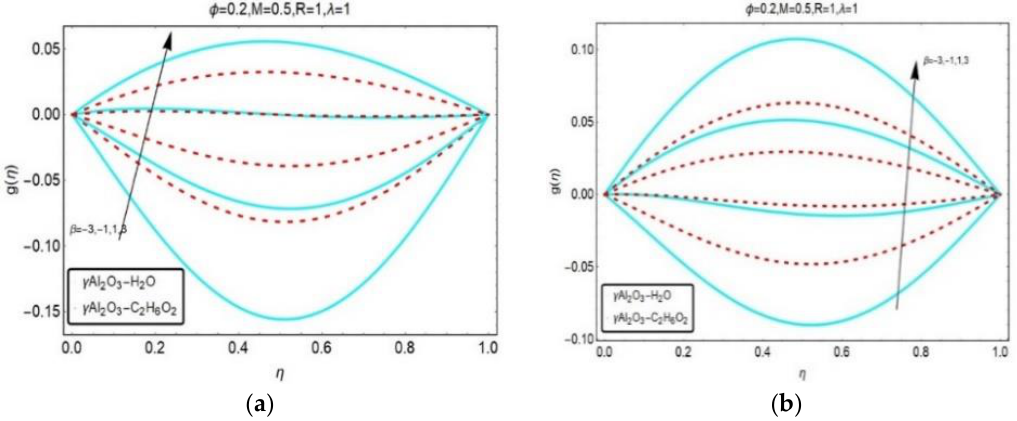
Figure 12. Influence of β on g ( η ) for ( a ) S > 0 and ( b ) S < 0.